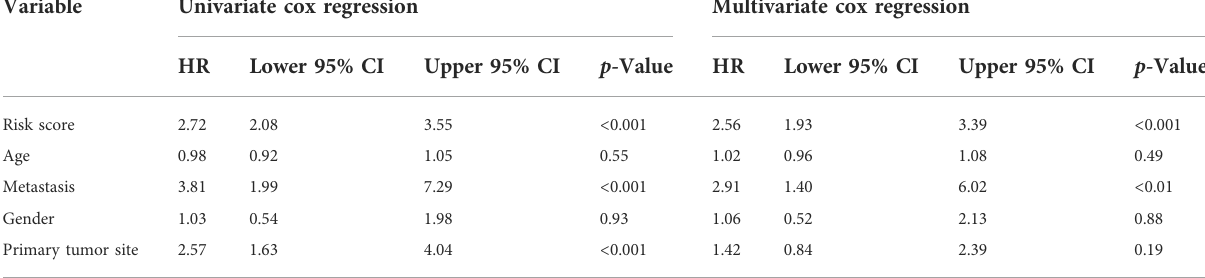
TABLE 3 Comparisons between the risk score and other four variables, including age, metastasis, gender, and primary tumor site in the TARGET dataset using univariate and multivariate Cox regression analyses. Variable